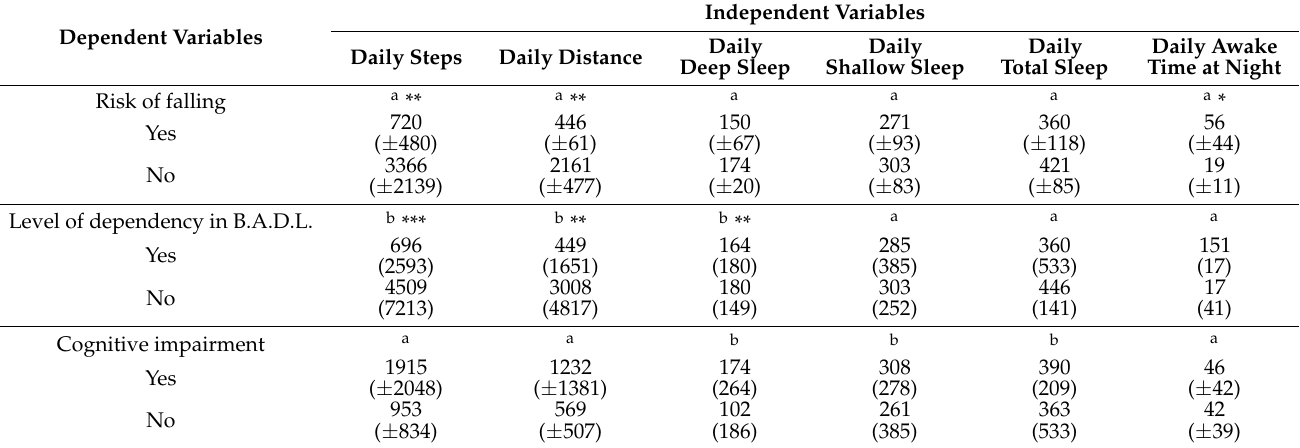
Table 3. Xiaomi Mi Band 2 parameter